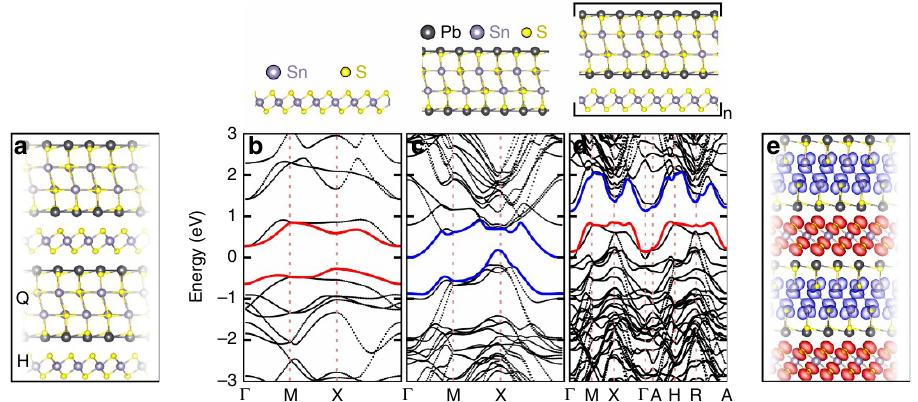
Figure 1 | Franckeite crystal and band structure. ( a ) Crystal structure of franckeite: the Q layer includes MX compounds, where M ¼ Pb 2 þ or Sn 2 þ (M can also be Sb 3 þ replacing Sn 2 þ ) and X ¼ S, while the H layer includes MX 2 compounds, where M ¼ Sn 4 þ (M can also be Fe 2 þ replacing Sn 4 þ ) and X ¼ S. ( b ) GGA band structure of the H layer that presents a bandgap of B 1eV. ( c ) Band structure of the Q layer which presents a bandgap of B 0.5eV. ( d ) Band structure of the franckeite crystal that presents a bandgap of B 0.5eV. The valence band states are provided by the H layer (red line), while the conduction band is given by the Q layer (blue line), suggesting that franckeite is a type-II heterostructure. ( e ) Bloch states in franckeite in which the valence (red) and conduction (blue) bands are